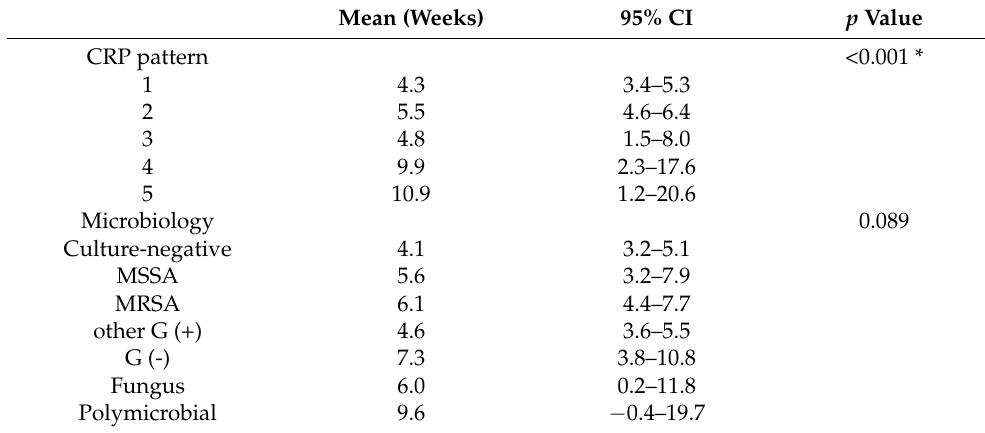
Table 3. Antibiotics duration. CRP type 4 and type 5 were associated with longer total antibiotic